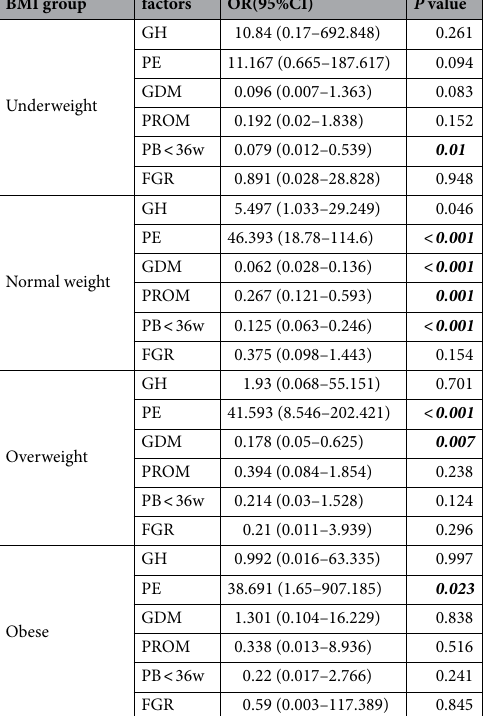
Table 5. Multivariable Logistic regression analysis result for weekly GWG impact on pregnancy complications grouped by BMI. P < 0.05 was considered statistically significant. CI confidence interval, OR odds ratio, GH gestational hypertension, PE preeclampsia, GDM gestational diabetes mellitus, PROM premature rupture of membranes, PB preterm birth, FGR fetal growth restriction. Confounding factor including age, height, prepregnancy weight, prepregnancy BMI. Significant values are in